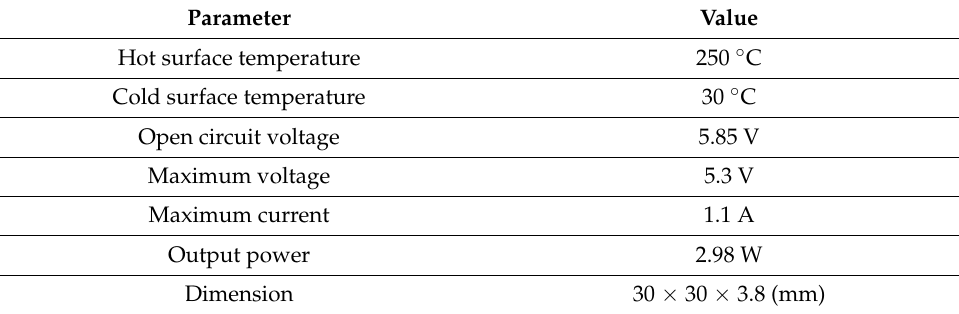
Table 5. Specifications of GM250-71-14-16 TEG module.